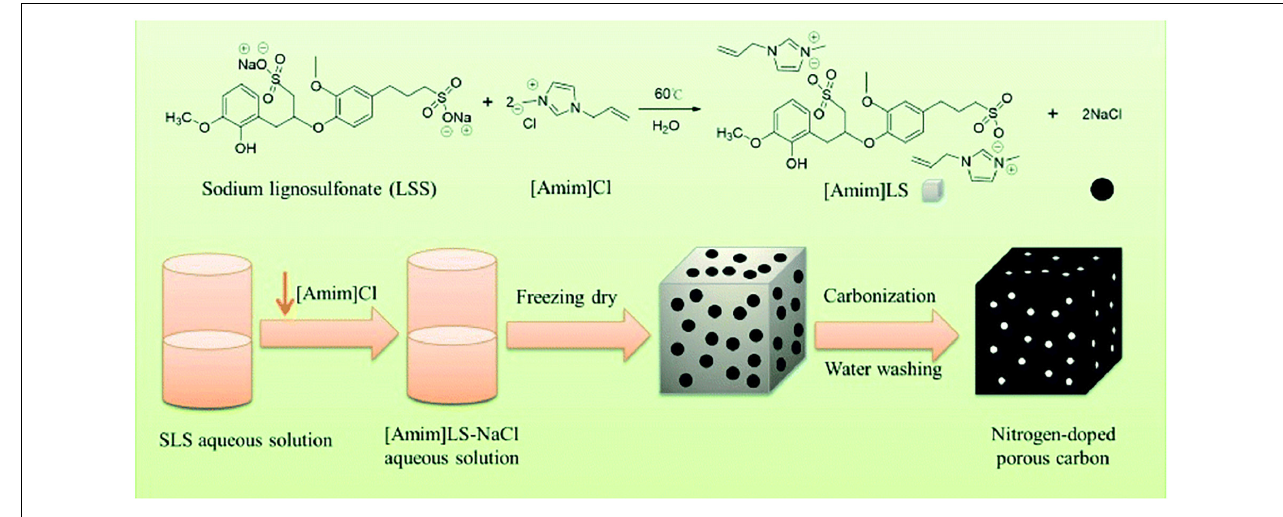
FIGURE 5 | Schematic diagram of [Amim]LS precursors for N-doped porous carbon material fabrication (Xu Q. Q. et al., 2020).